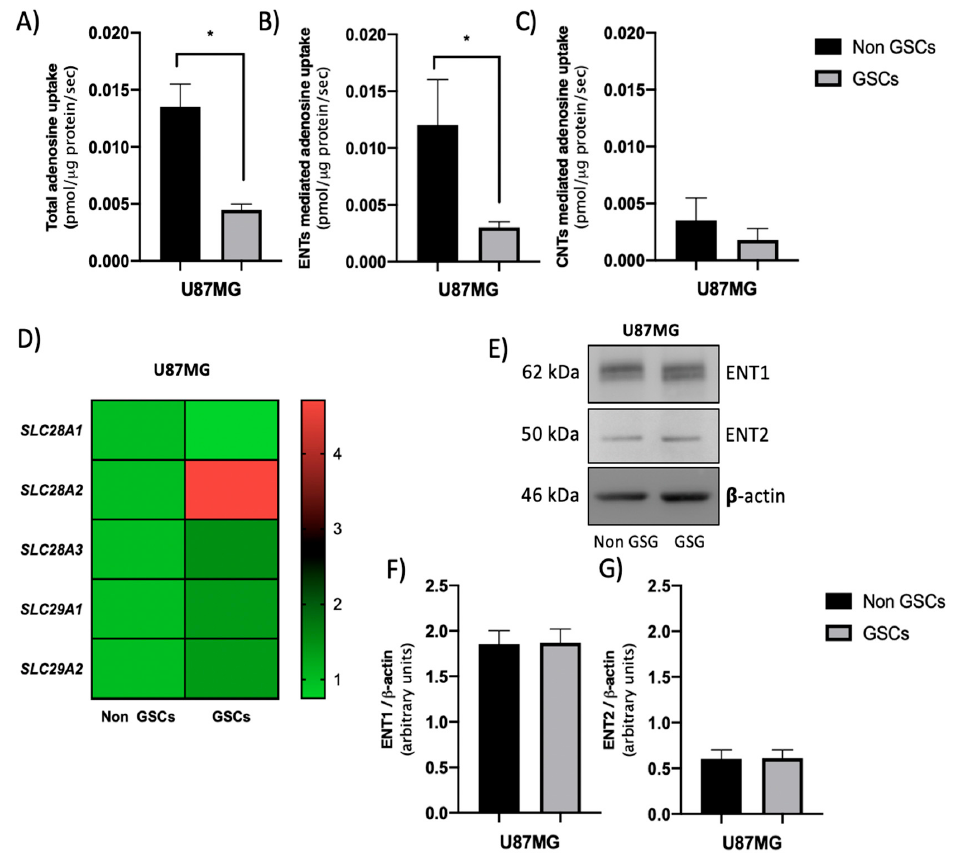
Figure 1. Adenosine transport activity in glioblastoma stem-like cells (GSCs) and non-GSCs.